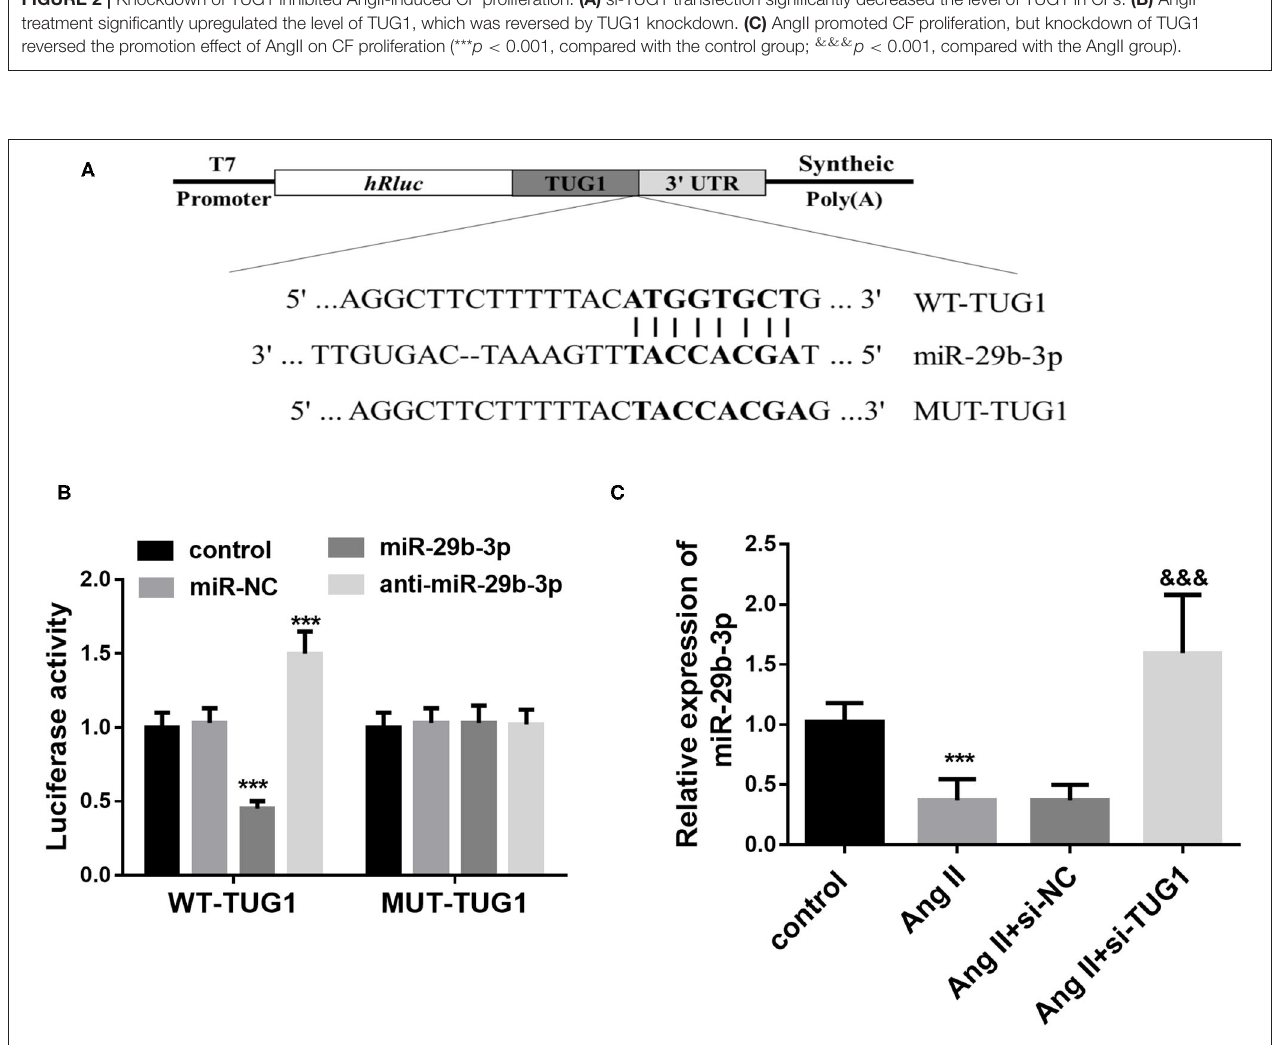
FIGURE 3 | TUG1 functions as a ceRNA for miR-29b-3p. (A) TUG1 contains complementary sequences that bind miR-29b-3p. (B) Overexpression of miR-29b-3p inhibited the luciferase activity of CFs transfected with TUG1-WT, whereas miR-29b-3p enhanced the luciferase activity. miR-29b-3p showed no significant influence on the luciferase activity of CFs transfected with TUG1-WT vector. (C) In the AF cell model, a low expression of miR-29b-3p was observed in AngII-treated cells, and TUG1 knockdown upregulated the expression of miR-29b-3p (*** p < 0.001, compared with the control group; &&& p < 0.001, compared with the AngII group).